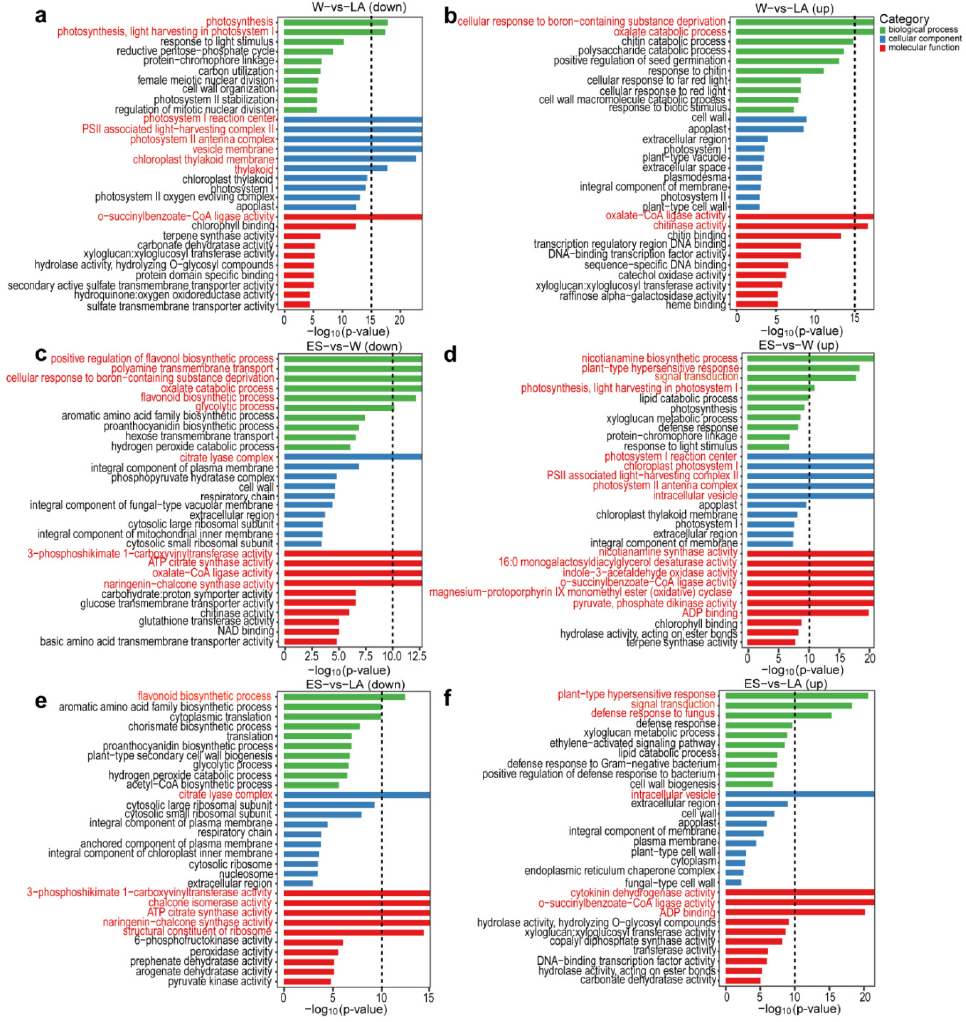
Figure 2. Gene Ontology (GO) functional annotation of differentially expressed unigenes (DEGs) in overwintering C. fortunei . ( a ) Downregulated DEGs in W vs. LA; ( b ) upregulated DEGs in W vs. LA; ( c ) downregulated DEGs in ES vs. W; ( d ) upregulated DEGs in ES vs. W; ( e ) downregulated DEGs in ES vs. LA; ( f ) upregulated DEGs in ES vs. LA. The x -axis represents − log 10 ( p -value), and the y -axis represents the enriched GO terms. Green bars, blue bars, and red bars represent biological process terms, cellular component terms, and molecular function terms, respectively. GO terms with red text represent terms with − log 10 ( p -value) > 15 or > 10. Sample abbreviations are as follows: ES, early spring; LA, late autumn; and W, winter.